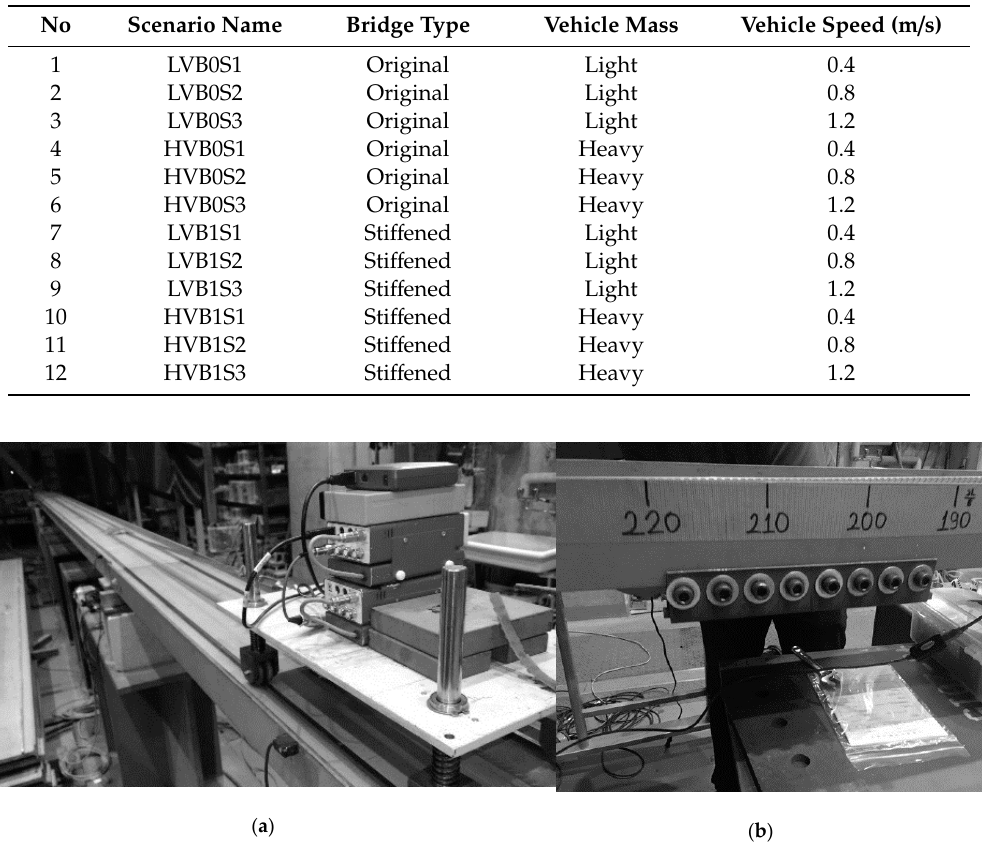
Figure 11. ( a ) Small scale bridge experiment; ( b ) a bridge span with a stiffened plate.